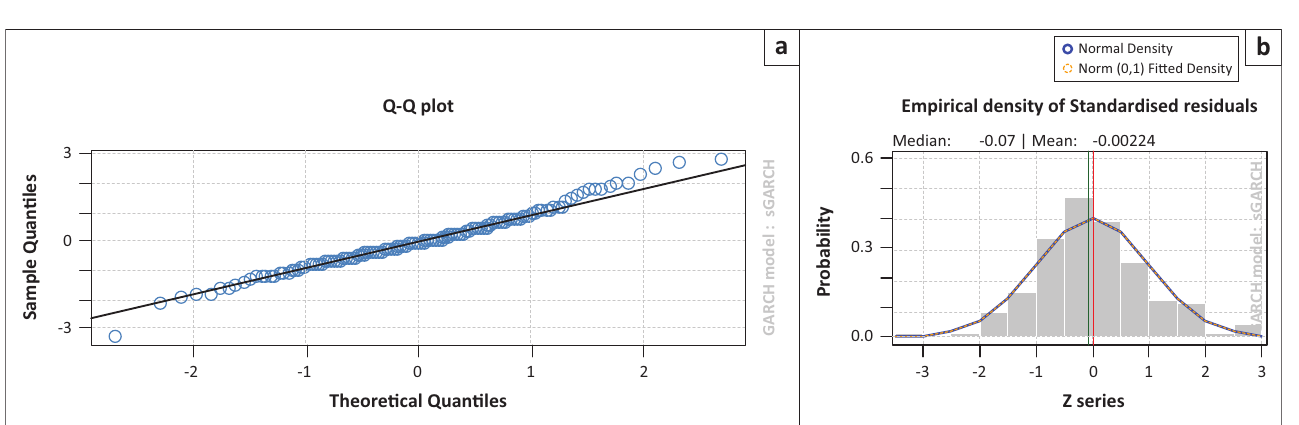
FIGURE 3: Autocorrelation function (ACF) of autoregressive conditional heteroscedasticity(1) process’ standardised residuals.